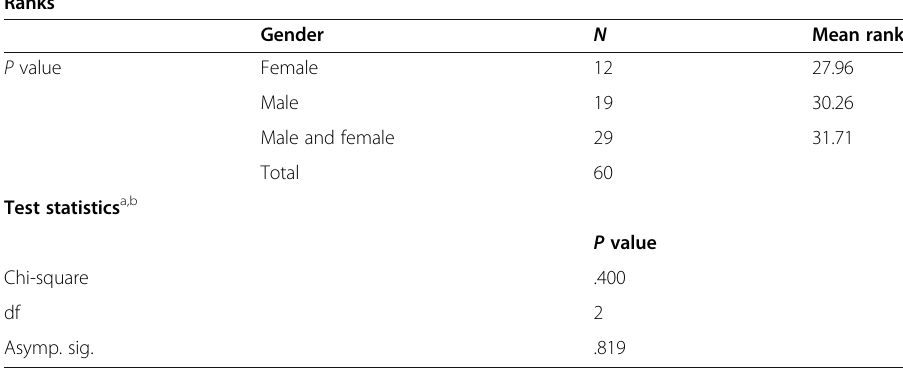
Table 17 Kruskal-Wallis test Ranks Gender N Mean rank P value Female 12 27.96 Male 19 30.26 Male and female 29 31.71 Total 60 Test statistics a,b P value Chi-square .400 df 2 Asymp. sig.